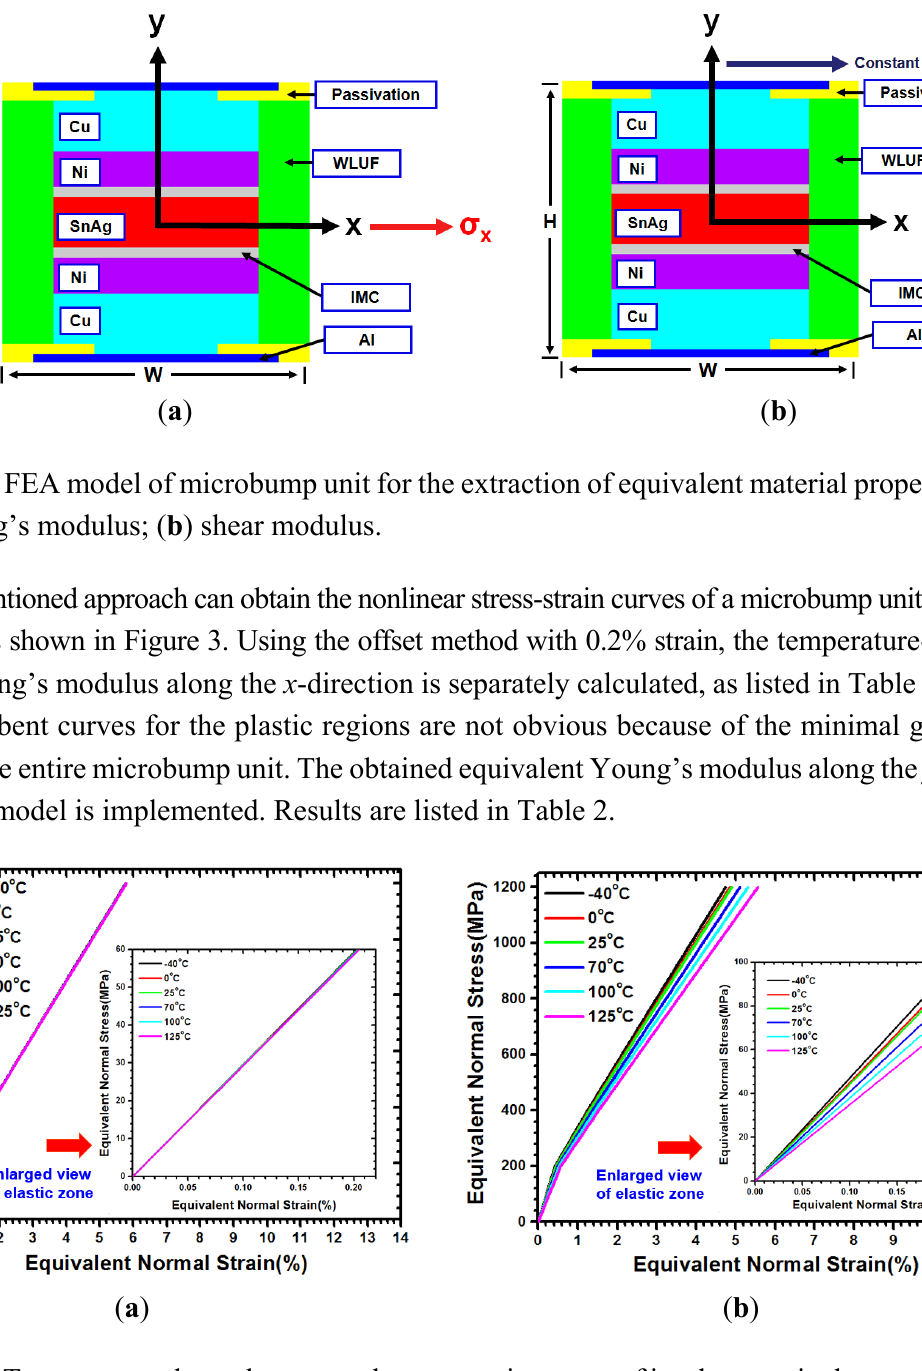
Figure 3. Temperature-dependent normal stress-strain curves of in-plane equivalent material for microbump unit with WLUF: ( a ) E x ; ( b ) E y